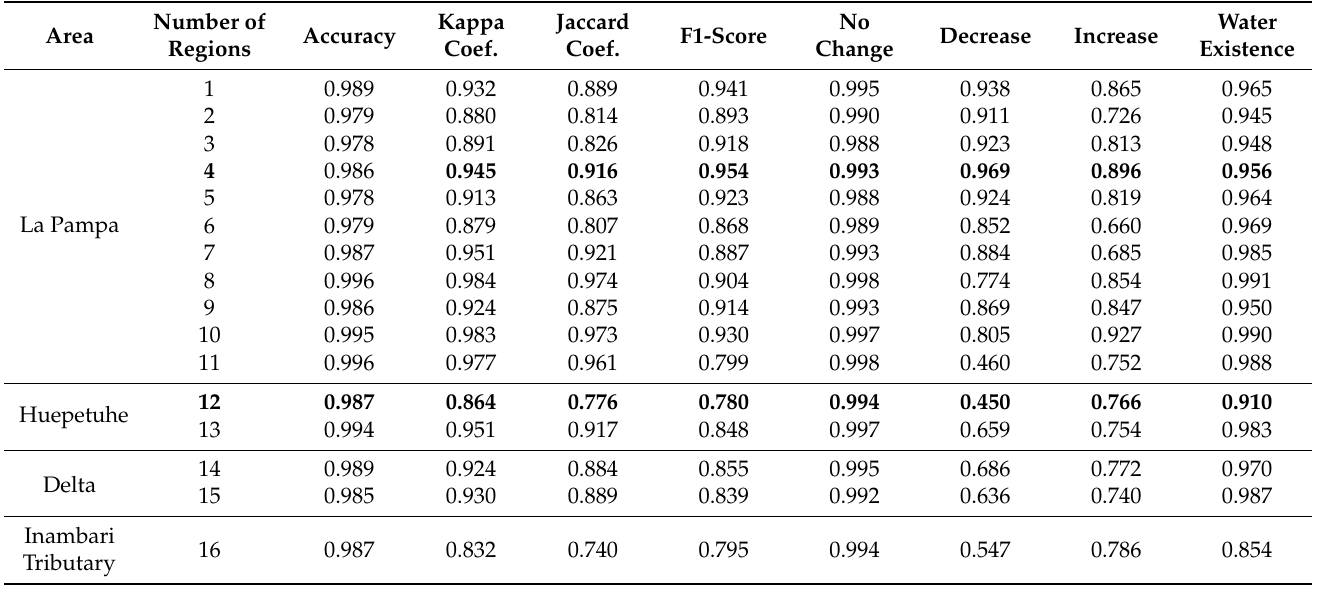
Table A4. Accuracies of regions and their areas for the E-ReCNN model for histogram-matched 6-Channel images. Region 4 and Region 12 were analyzed in Discussion section and given as an example of the difference kind of ponds.